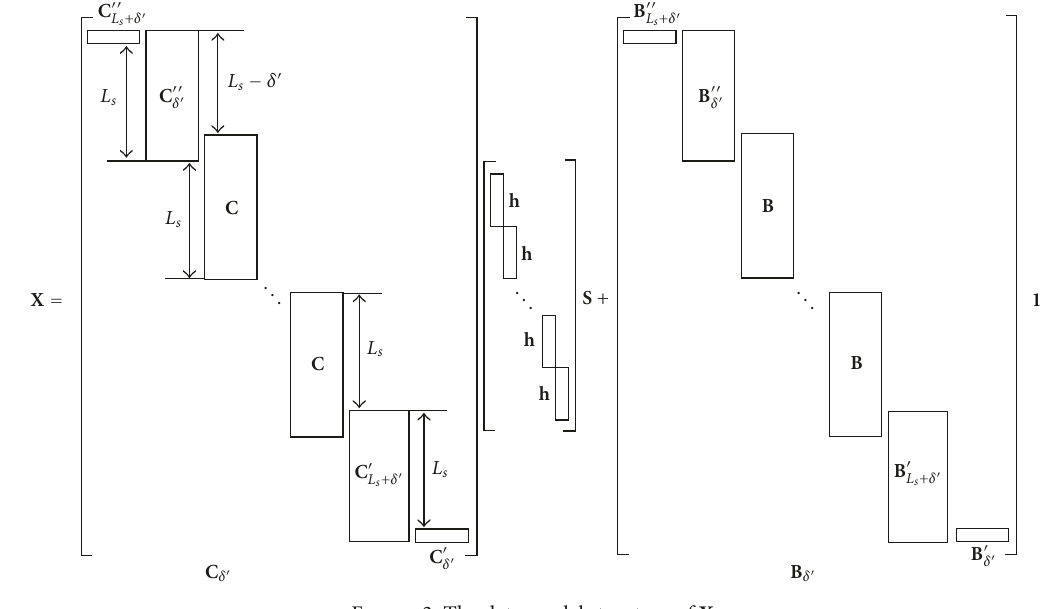
Figure 2: The data model structure of X .